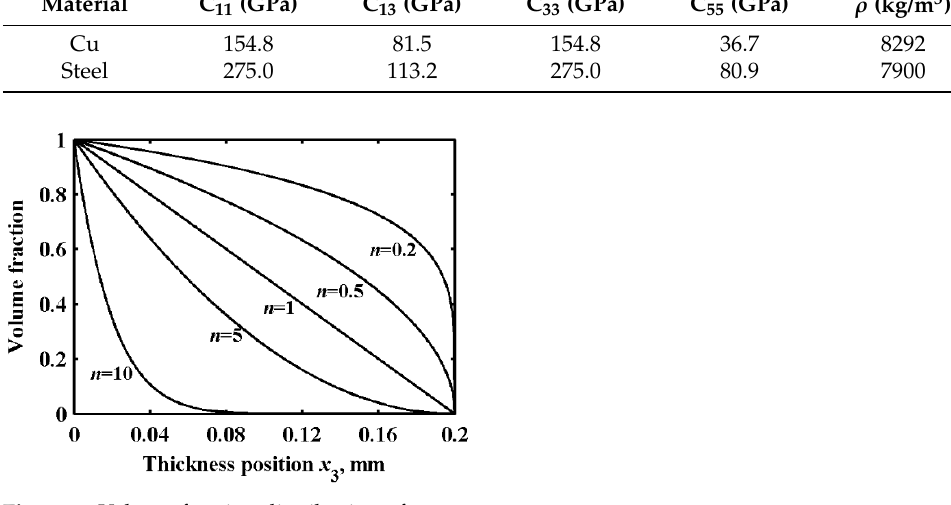
Figure 2. Volume fraction distribution of copper.